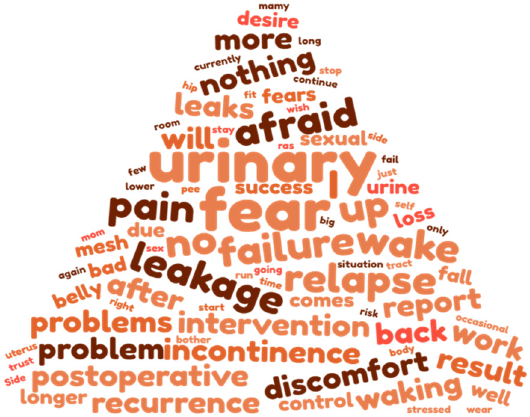
Figure 2. Women’s preoperative fears before cystocele repair.